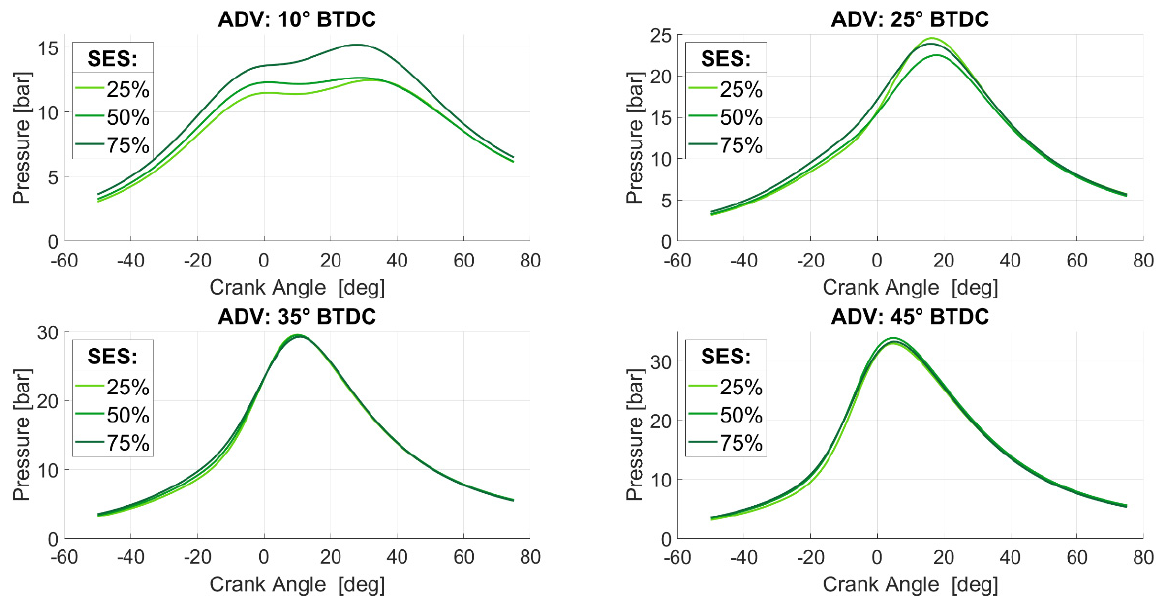
Figure 3. In-cylinder pressure developments for each of the three gas mixtures (SES 25%, 50%, and 75%) at different spark advance (10°, 25°, 35°, and 45° BTDC).